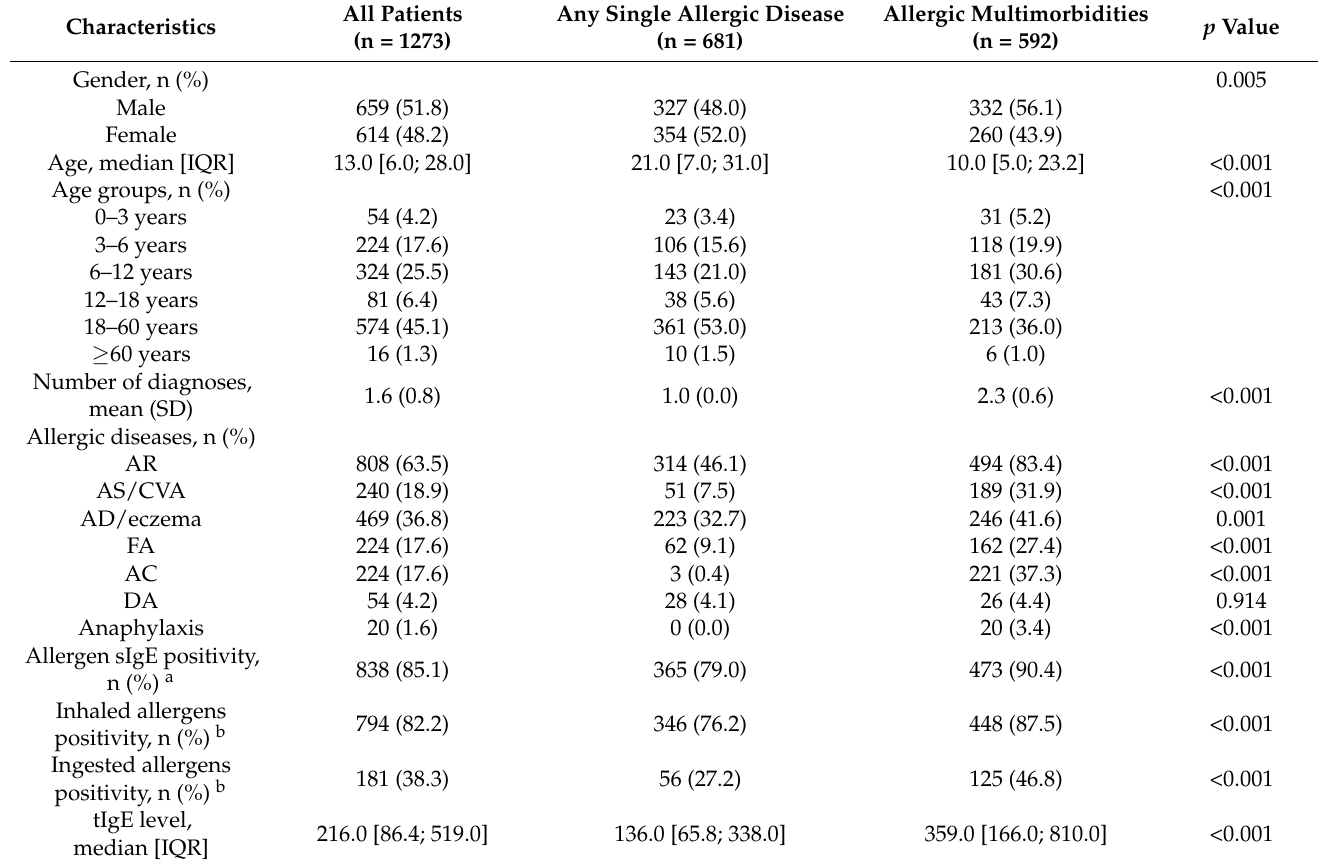
Table 1. Characteristics of patients with different allergic